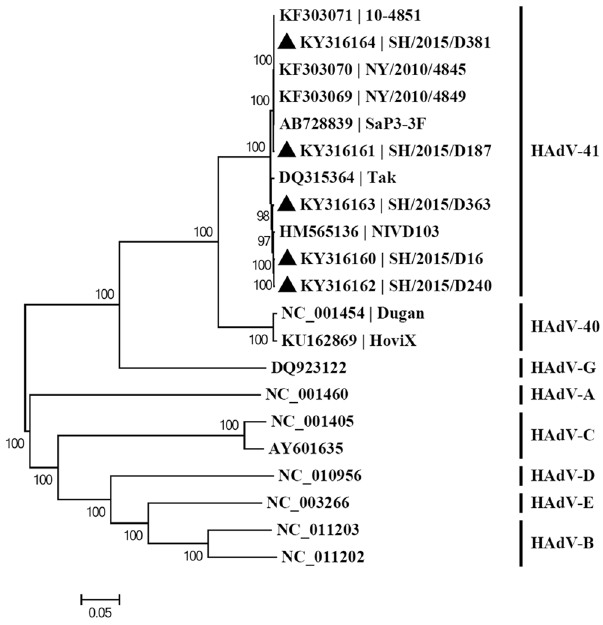
Figure 2. Phylogenetic tree of the five isolates, along with all available HAdV-F isolates and other representative HAdV species. The trees were constructed by neighbor-joining method using MEGA6 with 1,000 bootstrap replicates. Black triangles represent the 5 HAdV-41 isolates in this study. Numbers at tree nodes indicate percentages of bootstrap values. The GenBank accession numbers are contained in the name of